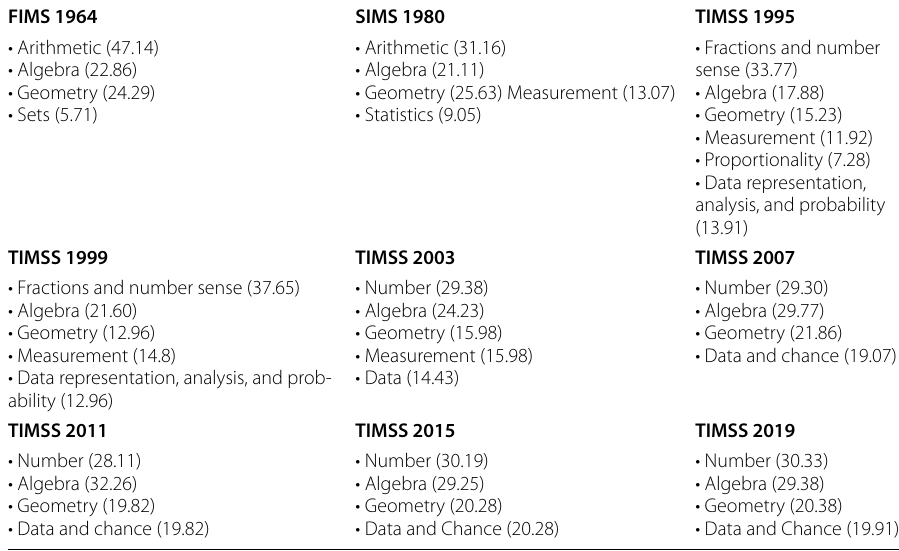
The percentage of items is shown in parentheses